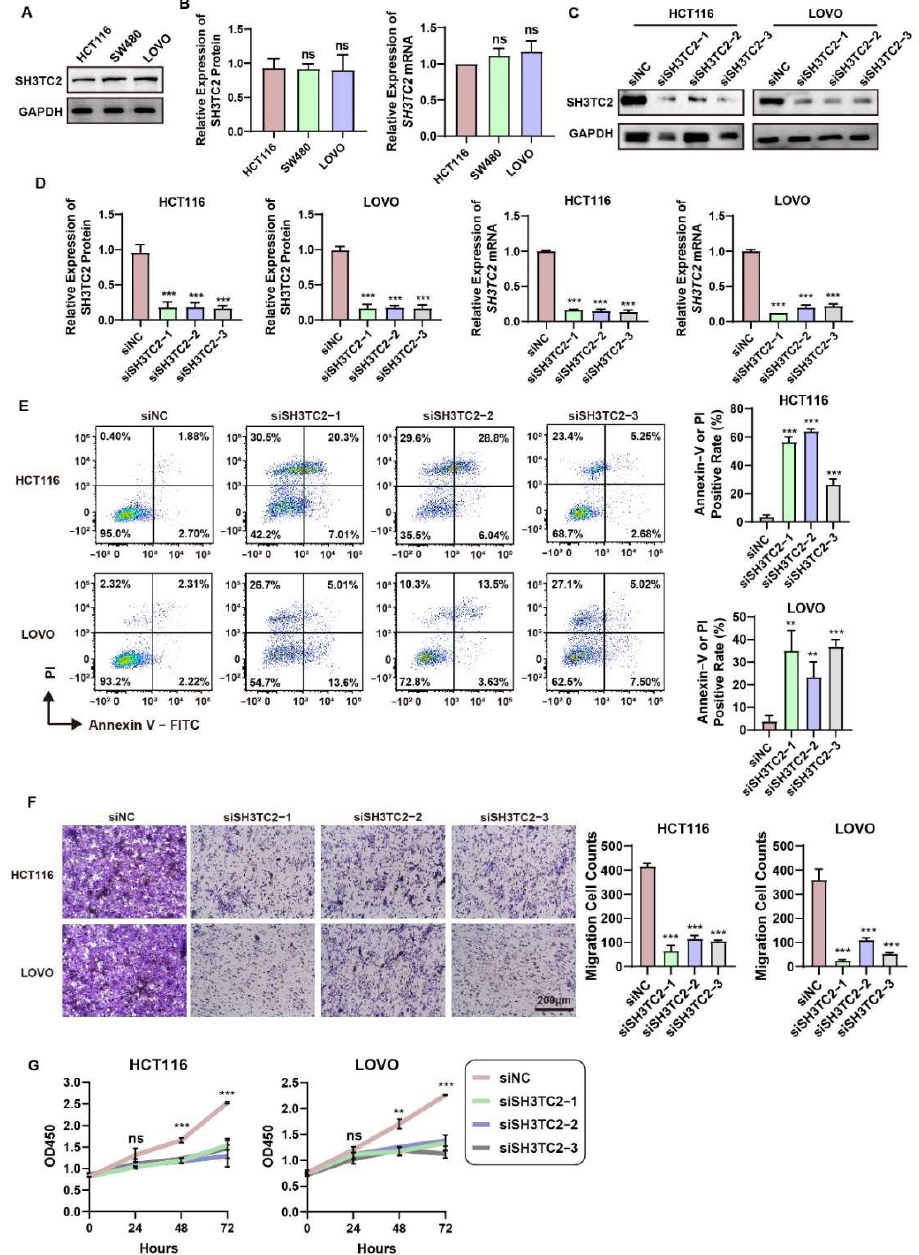
Figure 4. Downregulation of SH3TC2 inhibited tumor progression and promoted cell apoptosis. ( A ) Comparison of SH3TC2 expression in three CRC cell lines via Western blotting. ( B ) The